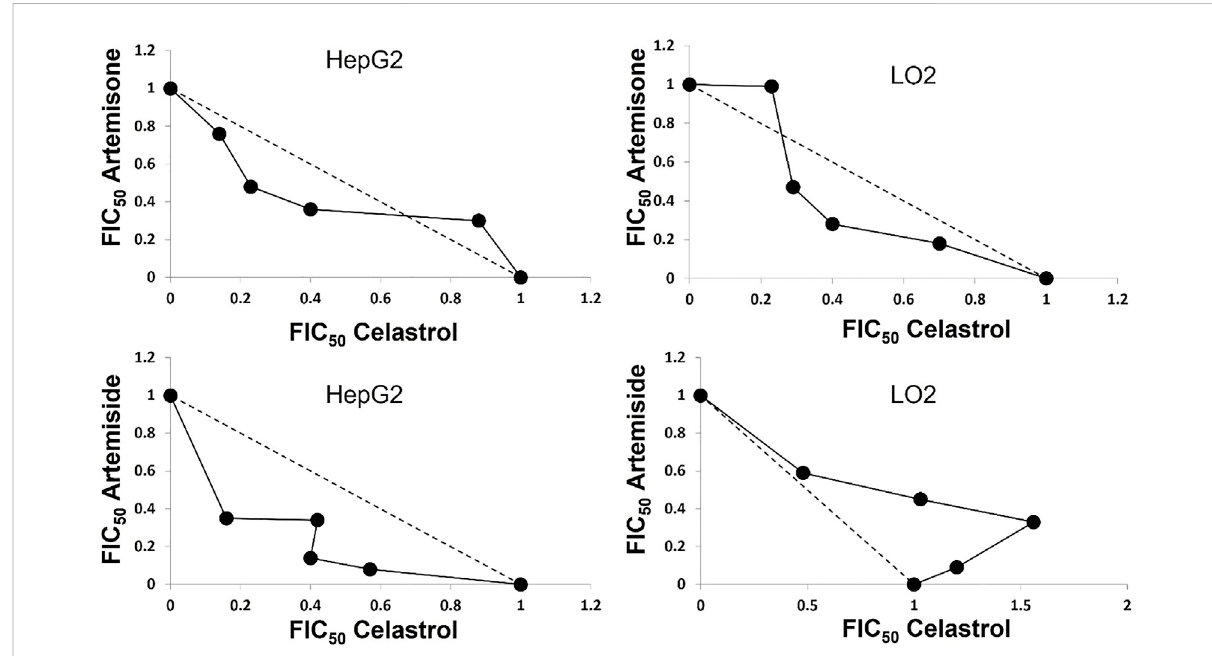
FIGURE 6 Isobole analyses of combinations of each of artemiside and artemisone with celastrol against HepG2 liver hepatocellular carcinoma and LO2 human normal hepatocyte cell lines; results are representative of four independent biological repeats (n = 4), each performed as technical triplicates, ±